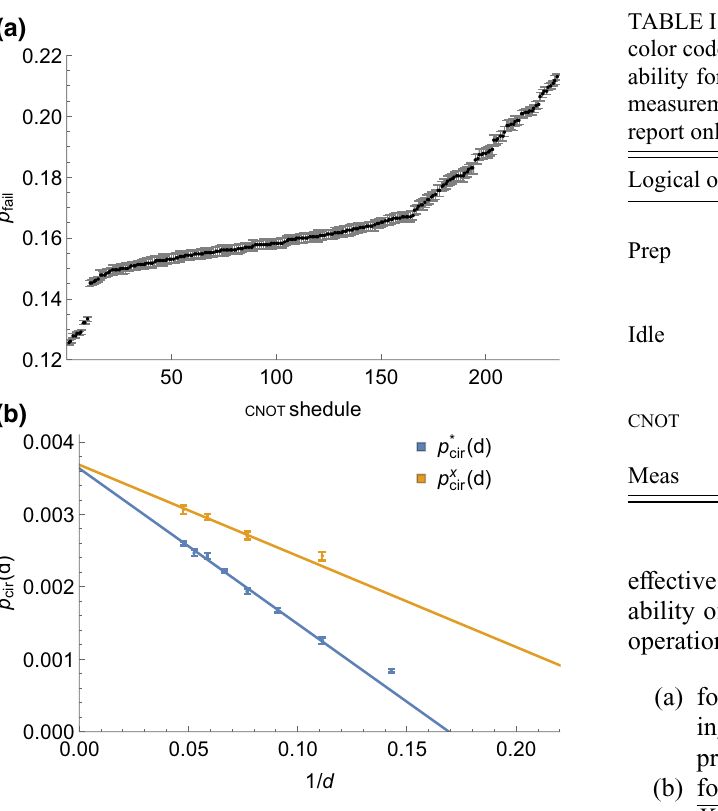
( d ) cir ( d ) and cir